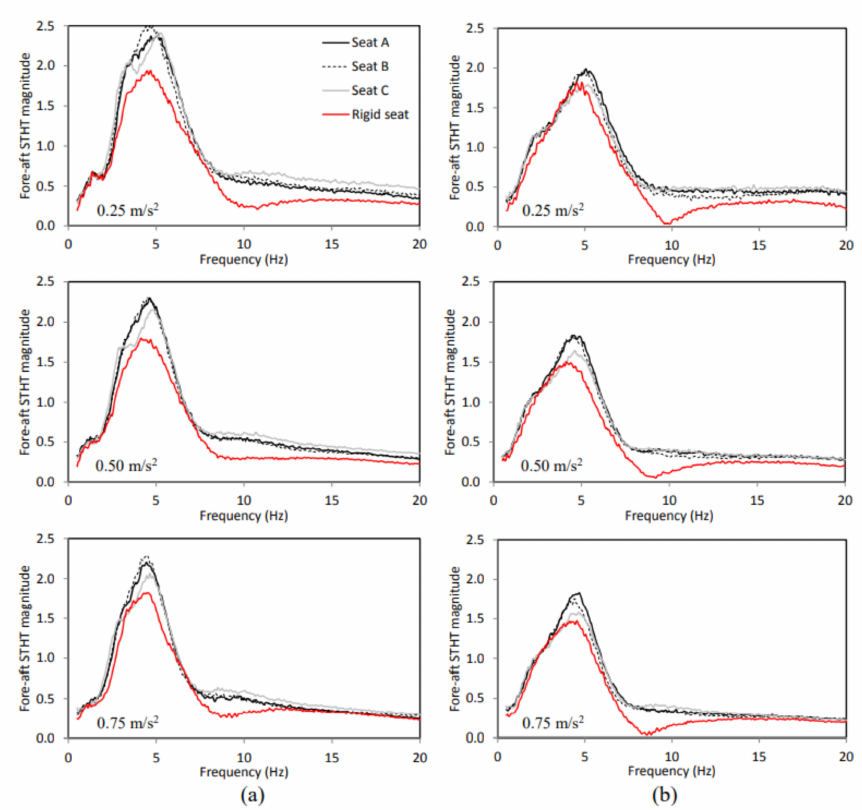
Figure 7. Mean fore-aft STHT magnitude of 58 participants sitting on the elastic and rigid seats and exposed to three excitations (0.25, 0.50 and 0.75 m/s 2 RMS acceleration): ( a ) without back support; and ( b ) with back